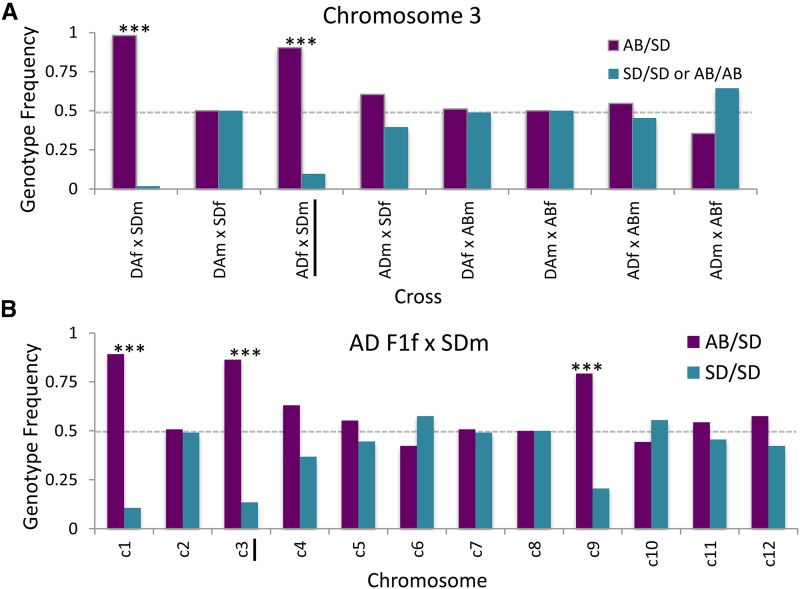
Backcrosses reveal the importance of intrachromosomal recombination for hybrids of T. californicus. (A) Progeny from the complete set of eight backcrosses genotyped for PCR-based marker 3d, with the genotypic frequency of the heterozygote and homozygote genotypic classes depicted. Only the two crosses using F1 hybrid females (with no recombination) show deviations from the expected 1:1 pattern of inheritance (*** denote a significant deviation with a Bonferroni correction). (B) A set of progeny from the AD F1f × SDm cross were scored for PCR-based markers on all 12 chromosomes, and the genotypic frequencies of heterozygotes and homozygotes at these 12 loci are shown. Two additional markers (c1 and c9) show significant deviations from the expected 1:1 ratios in these hybrid.